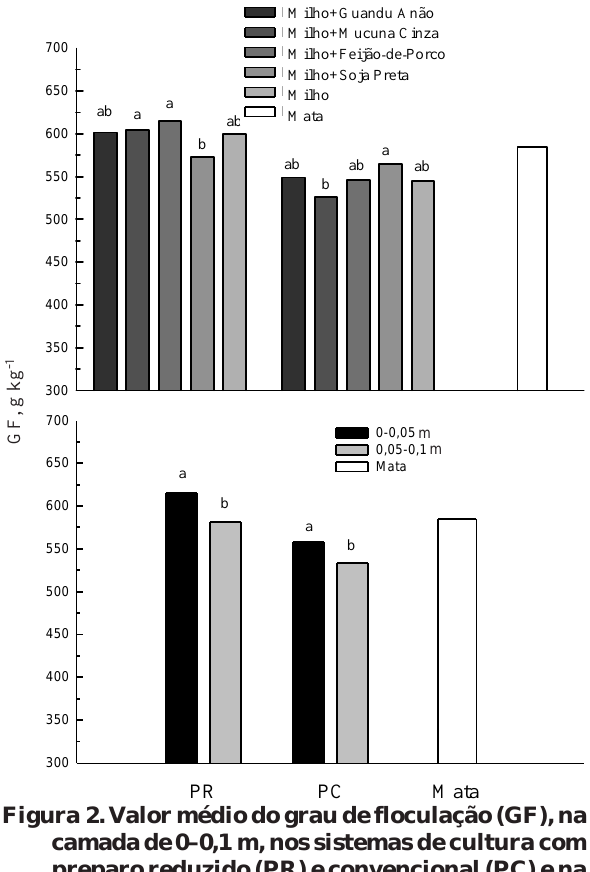
Figura 2. Valor médio do grau de floculação (GF), na camada de 0–0,1 m, nos sistemas de cultura com preparo reduzido (PR) e convencional (PC) e